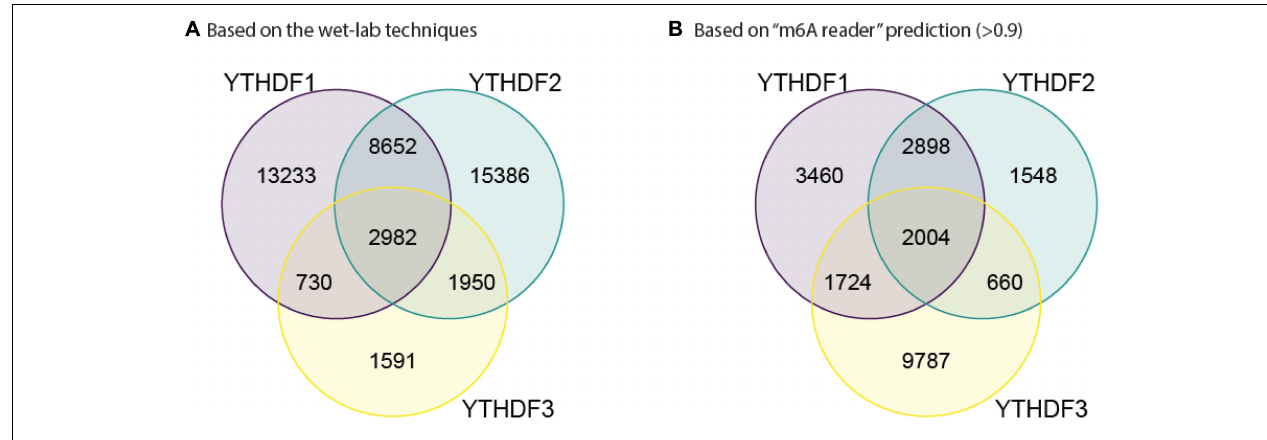
FIGURE 2 | Substrate overlap between YTHDF family.